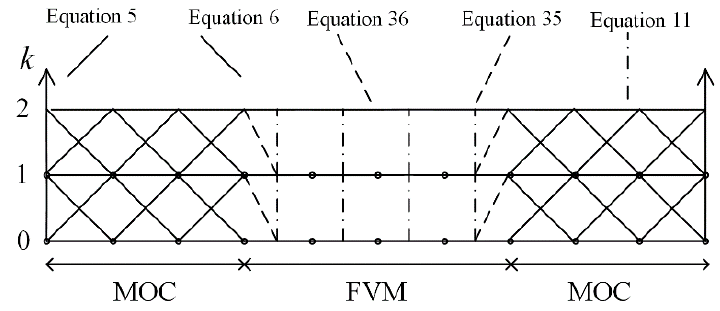
and vertical coordinates represent the space step and the time step, respectively. The dots on the horizontal coordinate are the grid nodes. In the MOC regions, the solid diagonals represent the calculation process of the C+ (Equation (5)) and C − (Equation (6)) equations and the vertical lines which are superposed on the vertical coordinates mean the boundary conditions that are determined by the system. In the FVM region, the vertical dot-dashed lines represent the calculation process of Equation (11). The dash lines in the leftmost grids in the FVM region represent the coupling boundary of Equation (36) and those in the right- most grids in the FVM region represent the coupling boundary of Equation (35). Starting from k = 0 with the initial parameters known, the simulation processes are represented by these lines in Figure 3.